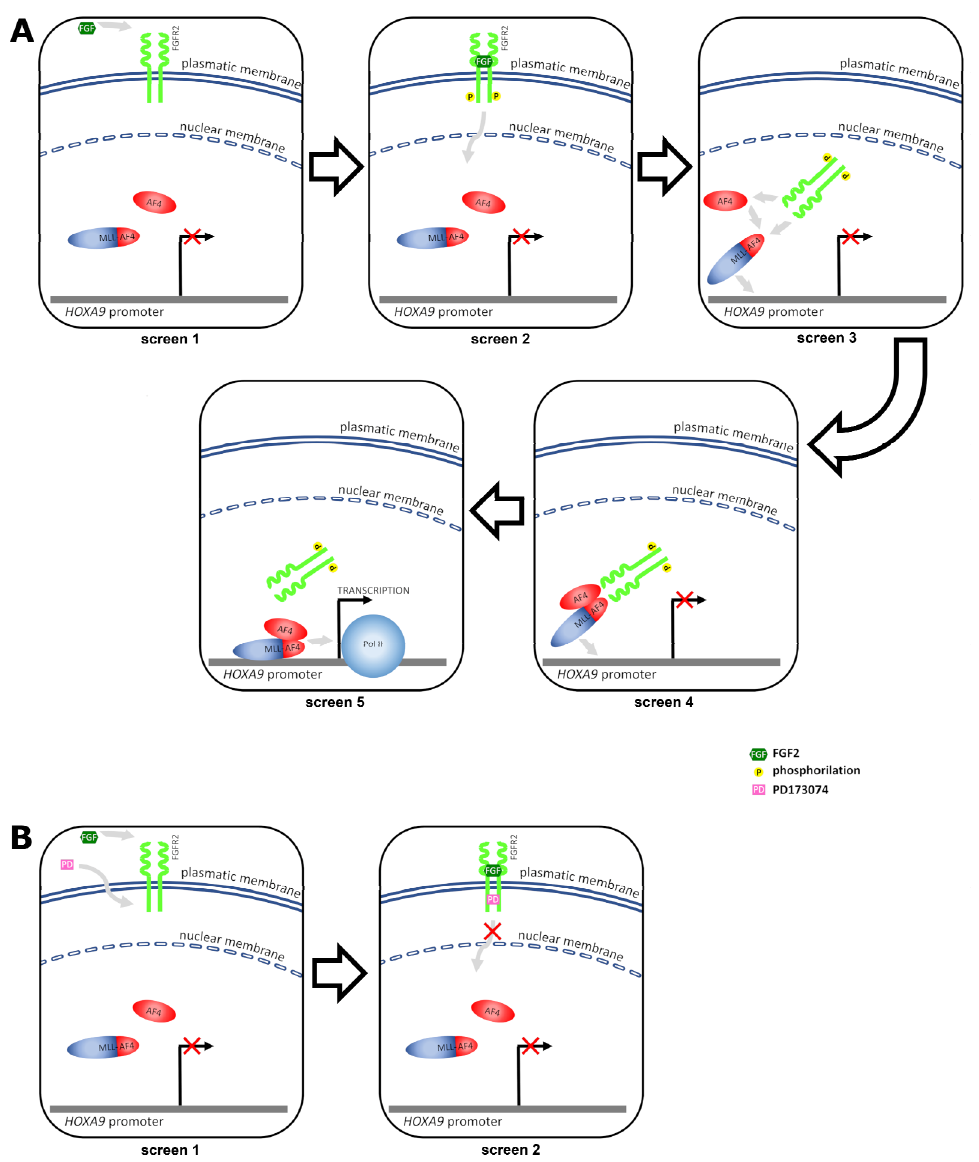
Figure 7. Nuclear cross-talk between FGFR2 and MLL-AF4 promotes aberrant transcription of HOXA9 in leukemia cells. ( A ) screen 1: in basal condition, HOXA9 transcription is not stimulated; screen 2: FGF2 binds FGFR2 and triggers its phosphorylation; screen 3: p-FGFR2 enters the nucleus and interacts with both the MLL-AF4 chimera and AF4; screen 4: p-FGFR2 promotes the binding of the MLL-AF4/AF4 complex to the HOXA9 promoter; screen 5: the MLL-AF4/AF4 complex activates RNA Pol II-dependent transcription of HOXA9 . ( B ) screen 1: the PD173074 inhibitor enters the cell, binds the ATP pocket of FGFR2, and prevents FGF2-mediated autophosphorylation of the receptor; screen 2: unphosphorylated FGFR2 does not enter the nucleus and therefore cannot promote the MLL-AF4-driven transcription of HOXA9 .